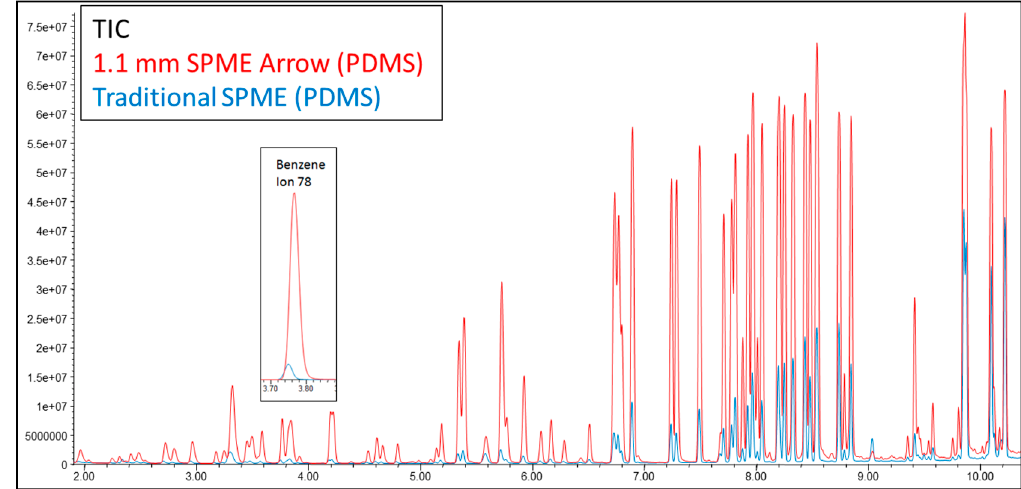
Figure 5. SPME Arrow overlay (TIC) on traditional SPME fiber for ISO 71943 headspace- volatile organic compounds (HS-VOCs) in drinking water. Acquired on Agilent 7890B/5977B GC-MS.